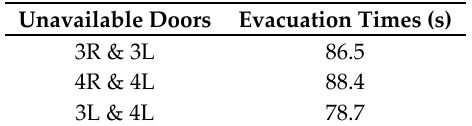
Table 7. Evacuation time in case of 2 exit doors are